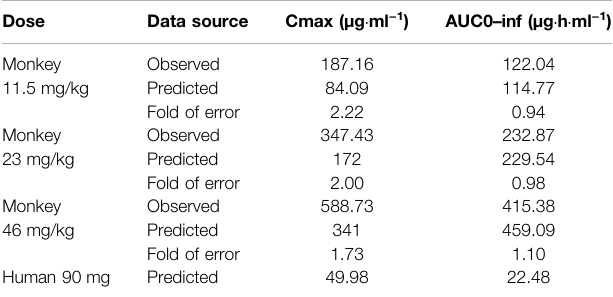
TABLE 3 | Plasma protein binding rates in vitro and in Rat, Monkey, and human plasma ( n (cid:1) 3).